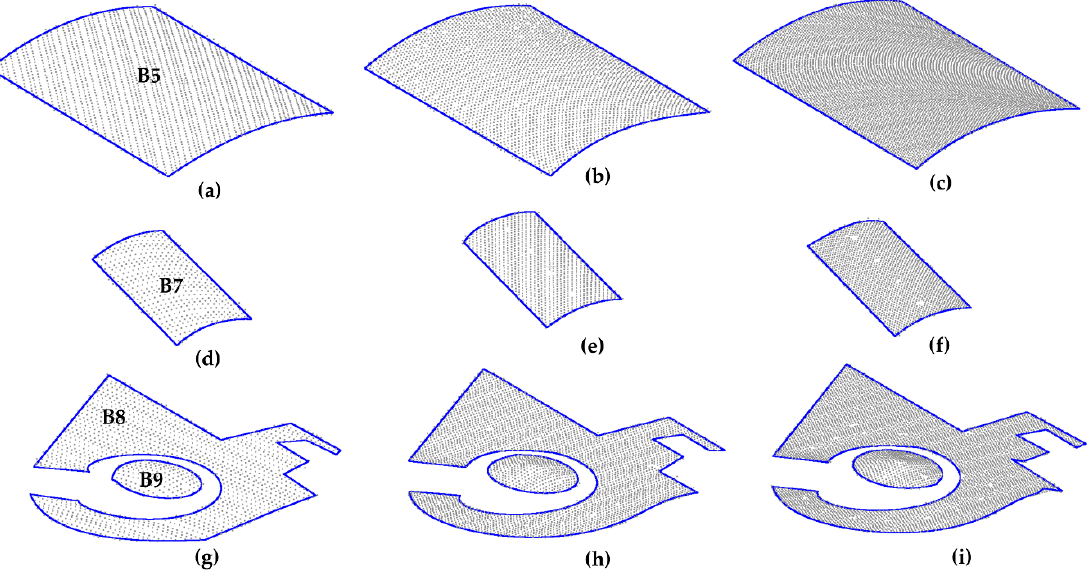
Figure 15. Boundary regularization results considering different point densities: 2.9 points/m 2 ( a , d , g ), 5.8 points/m 2 ( b , e , h ), and 12.5 points/m 2 ( c , f , i ).